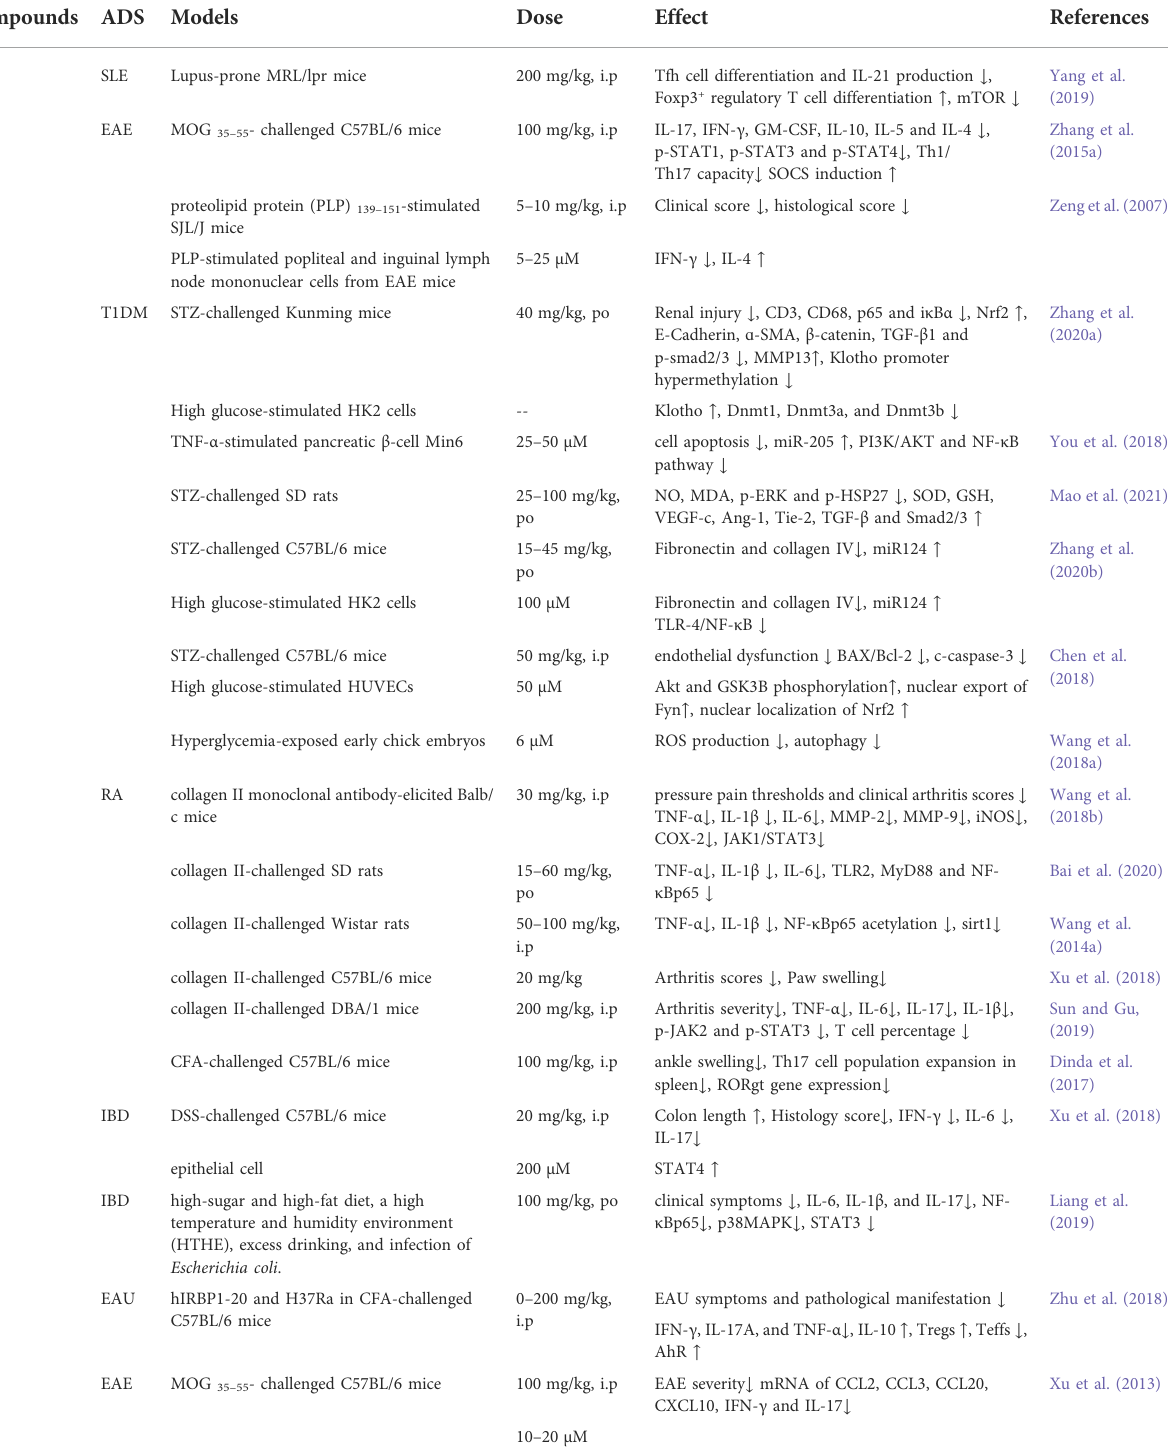
TABLE 2 JAK/STAT/mTOR, BAX/Bcl2/caspase-3/9, TLR4/NF- κ /PPAR, IL-4/PI3K/Akt/GSK3 β , TGF- β /Smad2/3,NLRP3/caspase-1/GSDMD and ROS/ Nrf2/HO-1 pathways are the principal signaling modulated by SBG and its compounds in ADS. The reported molecules regulated by SBG are marked with a red star.JAK/STAT/mTOR, BAX/Bcl2/caspase-3/9, TLR4/NF- κ B/PPAR, IL-4/PI3K/Akt/GSK3 β , TGF- β /Smad2/3,NLRP3/caspase-1/ GSDMDandROS/Nrf2/HO-1pathwaysaretheprincipalsignalingmodulatedbySBGanditscompoundsinADS.Thereportedmoleculesregulatedby SBG are marked with a red